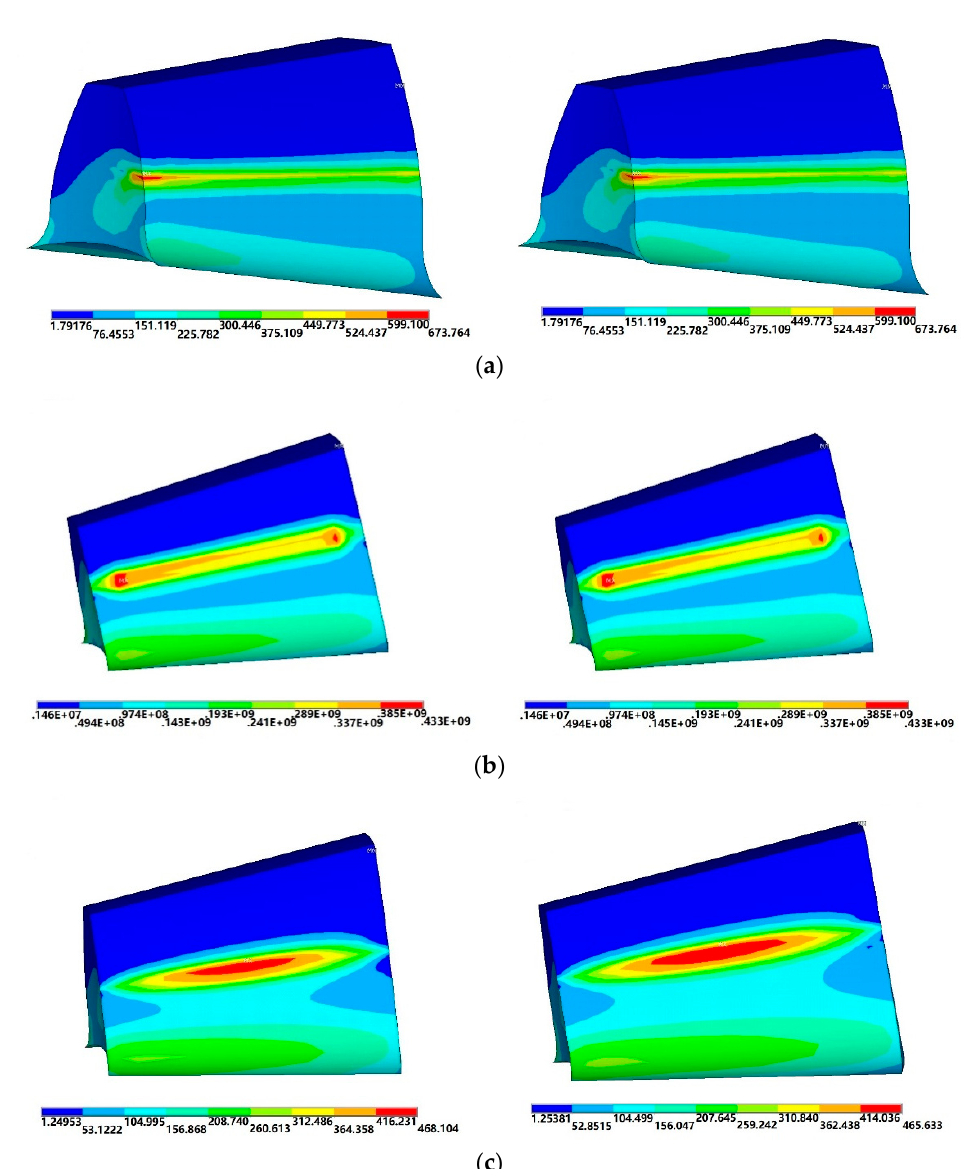
Figure 13. Distribution of contact stress on the tooth surface for pinion (left) and the gear (right) when ∆ E = 0.02. ( a ) No modification, ( b ) Case4 and ( c ) Case1.